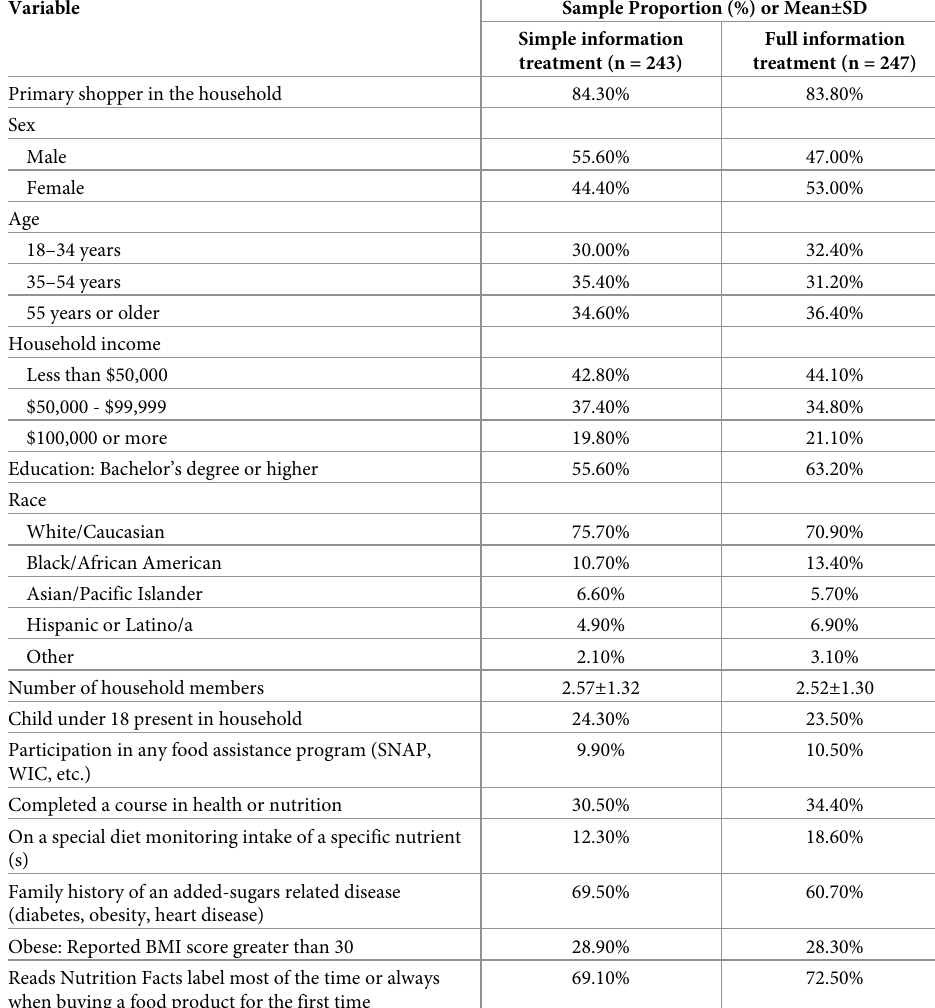
Table 1. Summary of sample